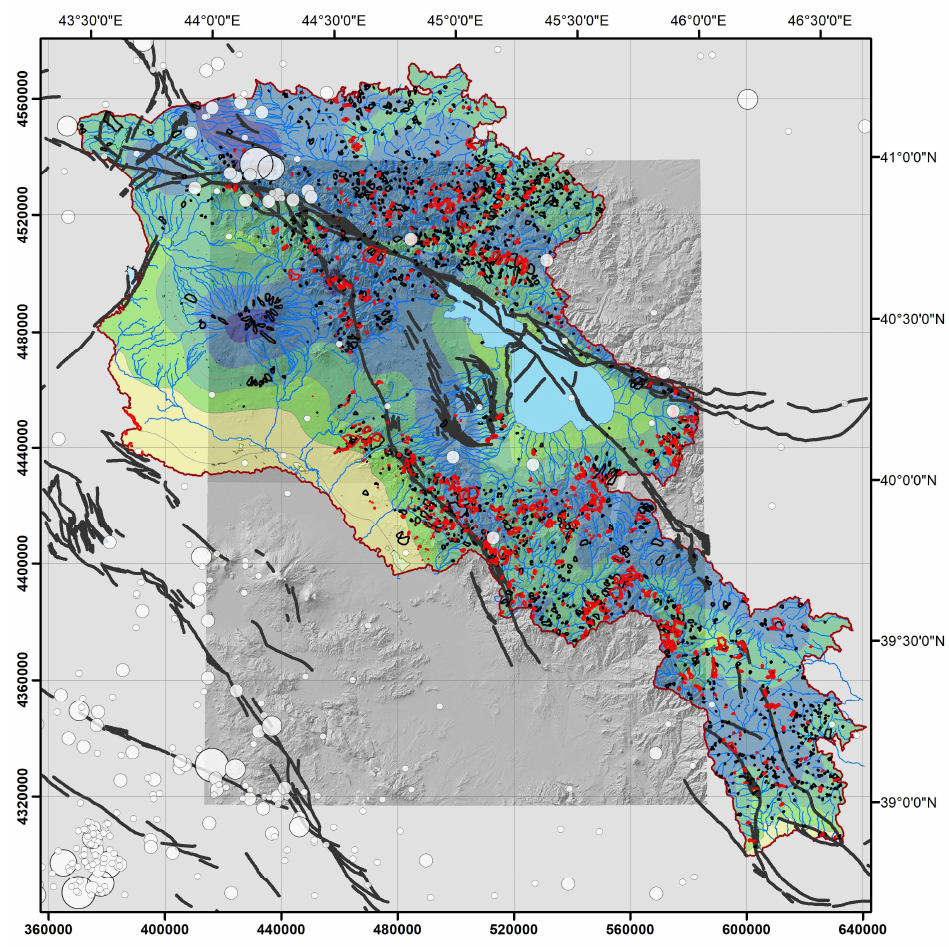
Figure A2. Map of the Armenian part of the Lesser Caucasus with the same inputs as Figure 2, overlaid on the interpolated annual average precipitation map of Armenia (yellowish-green colours for annual precipitation < 500 mm, bluish colours for maximum amounts of 1000 mm in the NW Aragats region).